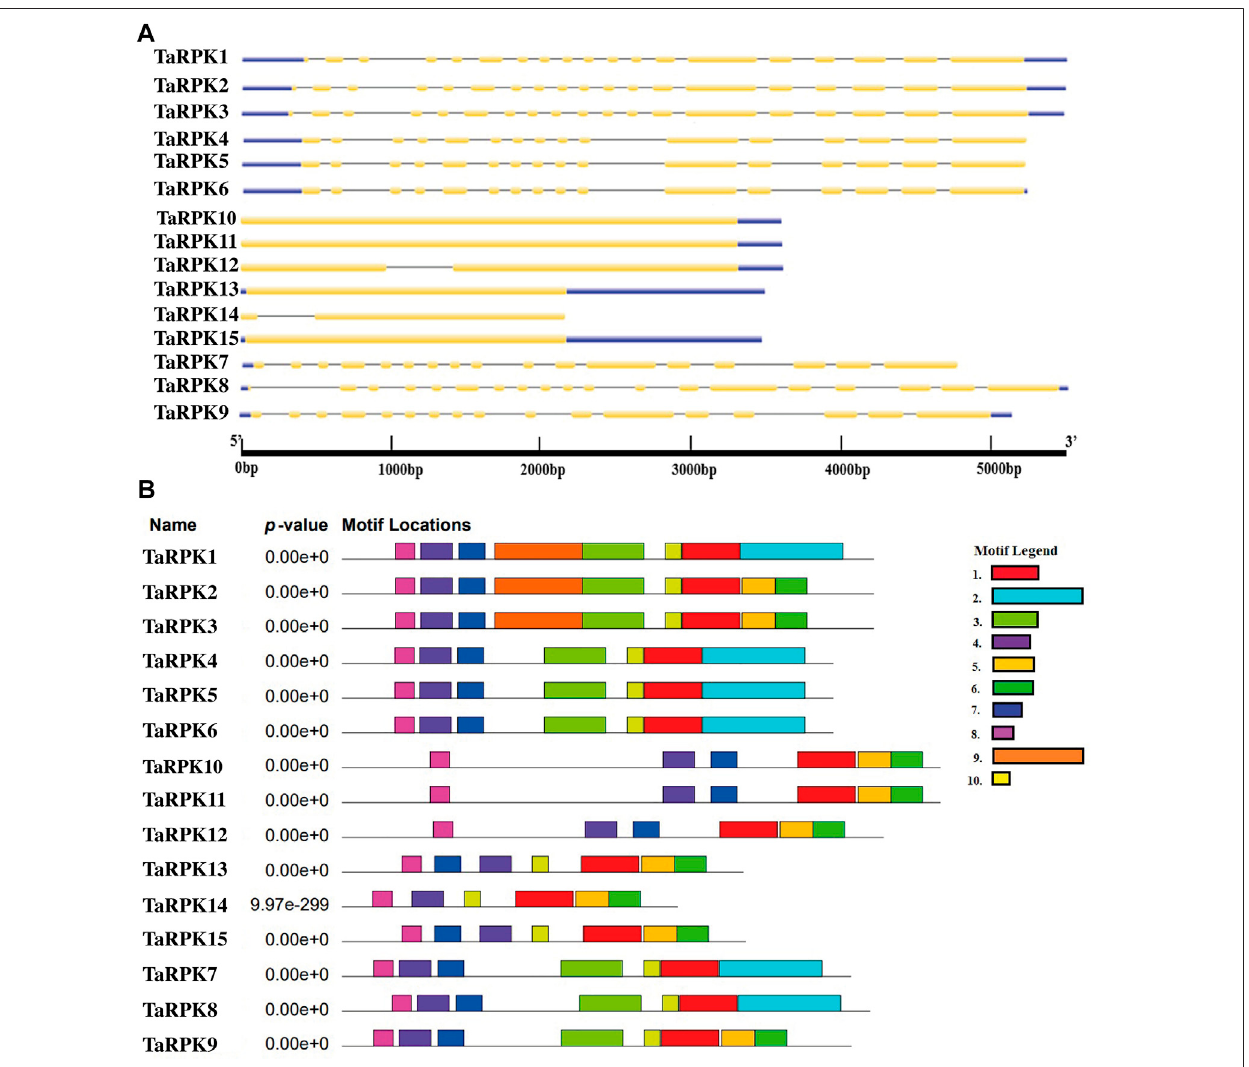
FIGURE 3 | (A) Exon – intron structures of T. aestivum RPK1 genes. Yellow boxes denote exons, straight black lines represent introns, and blue boxes denote upstream/downstream. (B) Schematic representation of identi fi ed motifs in T. aestivum RPK1 proteins using the MEME motif search tool. Different colors indicate different